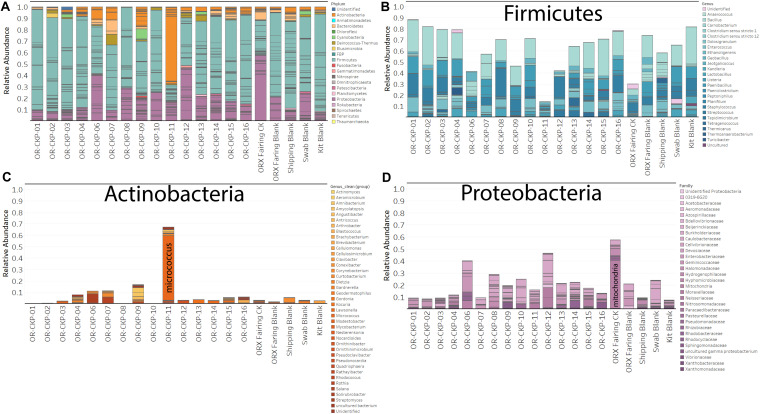
Bar charts detailing bacterial and archaeal sOTUs identified in each sample. Bars are colored by phyla in (A). Abundant phyla are presented with genus level identifications (B,C) or family level identifications (D). The most abundant phylum in most samples is Firmicutes (Blue bars; A,B).